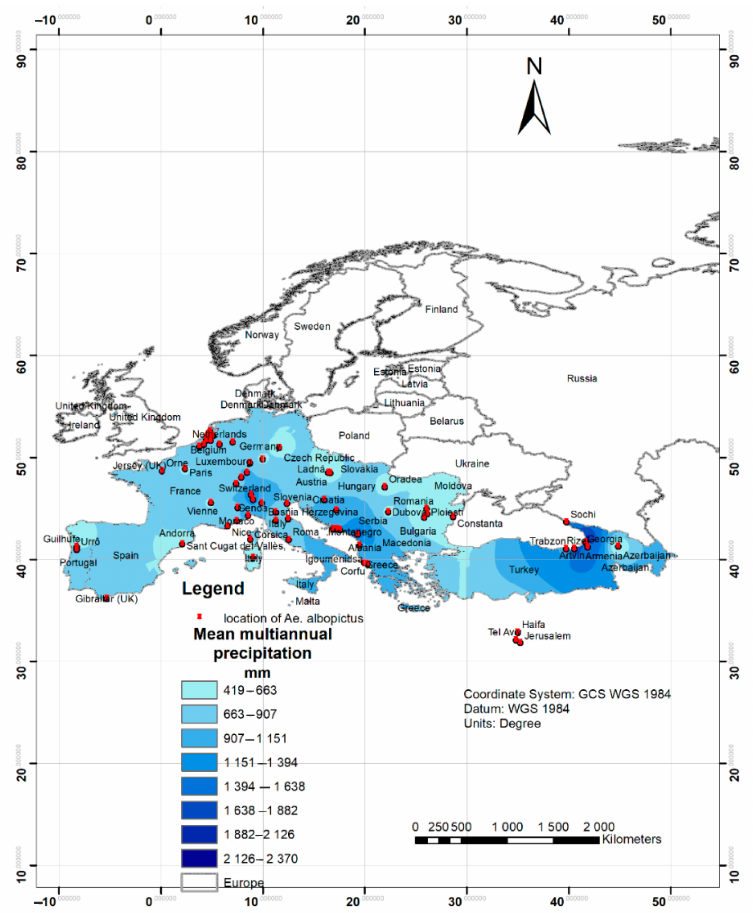
Figure 5. The mean multiannual precipitation in the area where the Ae. albopictus was